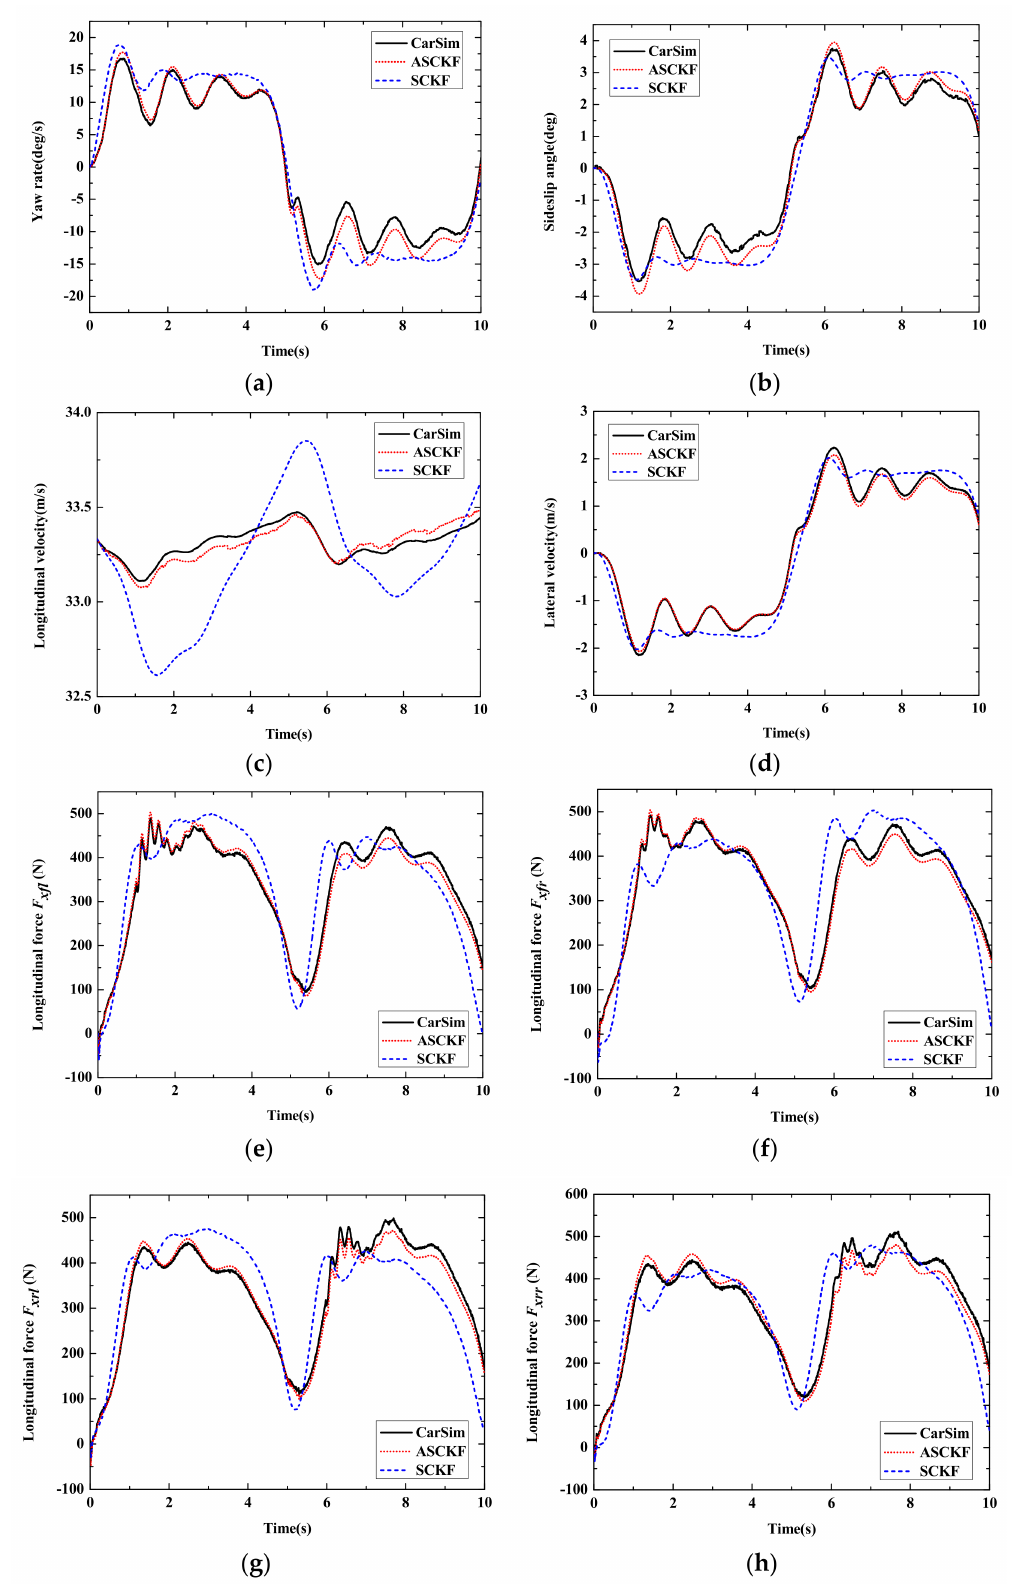
Figure 8. Estimation results of Case1. ( a )Yaw rate; ( b ) Sideslip angle; ( c ) Longitudinal vehicle speed; ( d ) Lateral vehicle speed; ( e ) Longitudinal force F fl ; ( f ) Longitudinal force F fr ; ( g ) Longitudinal force F rl ; ( h ) Longitudinal force F rr